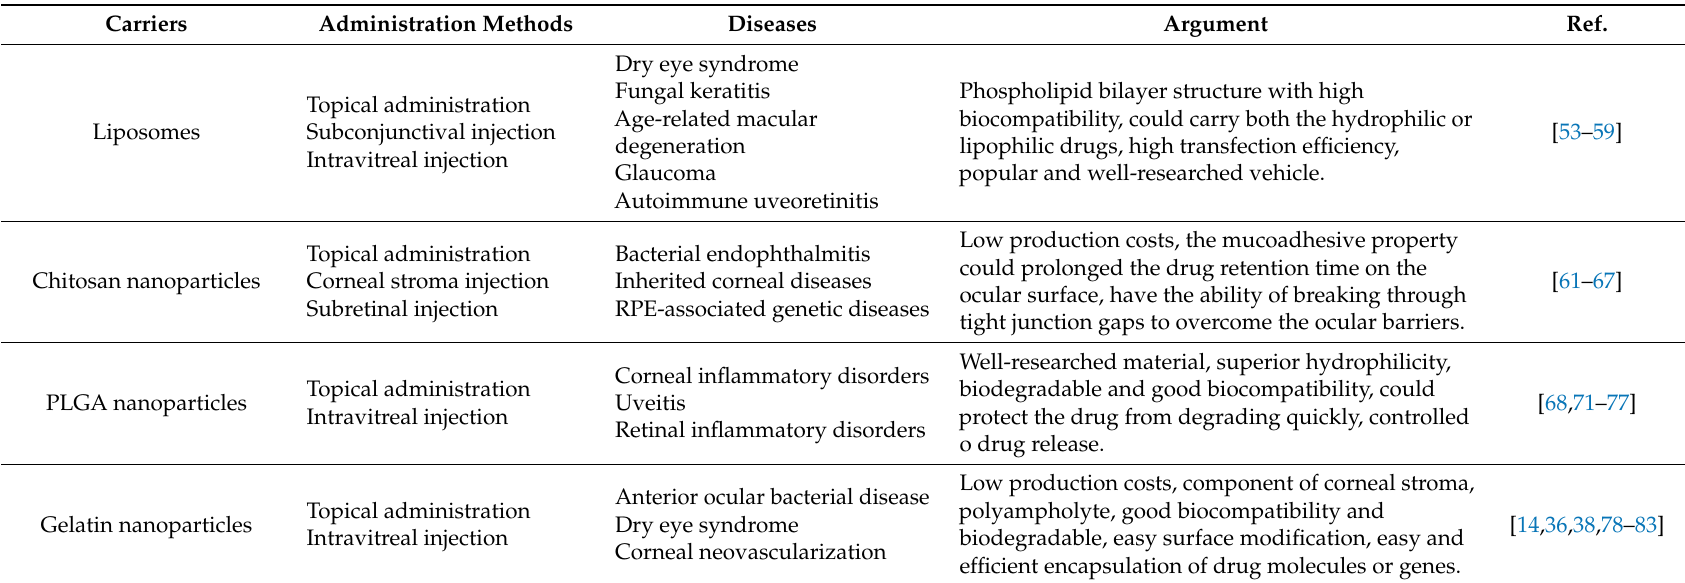
Table 2. Summary of common colloidal biodegradable nanoparticles in